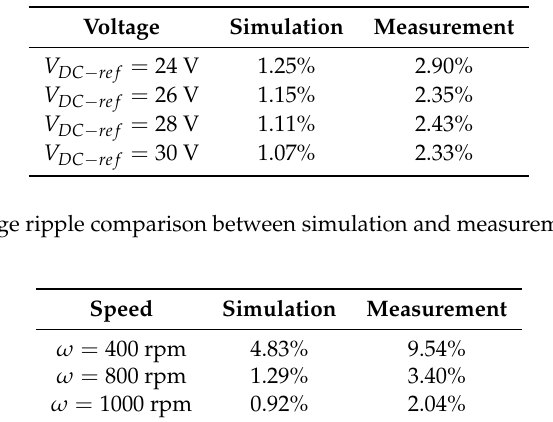
Figure 15. DC bus voltage regulation for different loads, at ω = 800 rpm. Table 2. DC bus voltage ripple comparison between simulation and measurement at ω = 800 rpm and R L = 15 Ω .